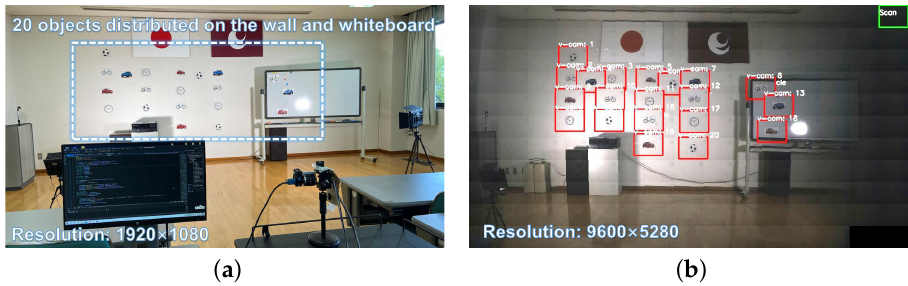
Figure 6. The 1920 × 1080 input images from the digital camera and the panoramic stitched 9600 × 5280 images from the PTZ camera: ( a ) overview of the experimental scene and ( b ) panoramic stitched image from the PTZ camera (targets are pasted on the panoramic image in the form of a red frame texture).